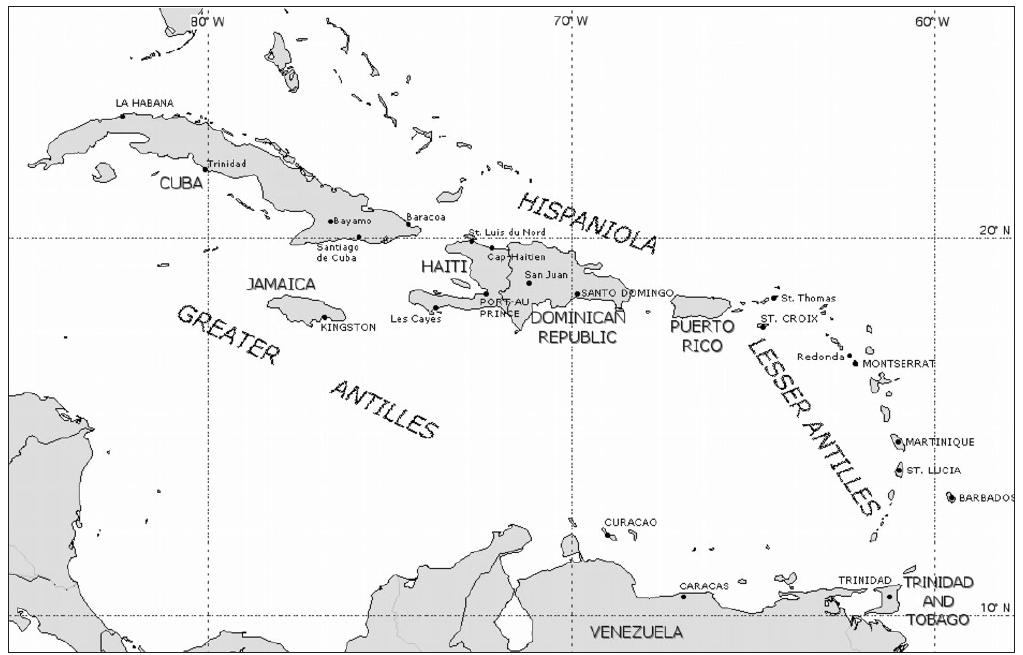
Fig. 1. Greater and Lesser Antilles: places mentioned in the